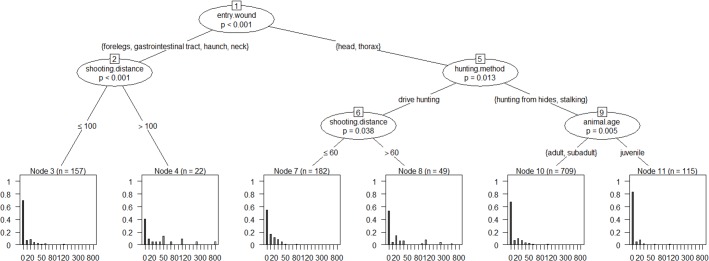
Inference tree for assessment of the factors that influence the escape distance of roe deer (including animals that remained on the spot).The inference tree can be read from top to bottom. The number of the splits (nodes) is shown in the boxes (e.g. 1). Significant variables are indicated at the splits with the significance level in the ellipses. Connections between the nodes show the group distributions. The escape distance is shown as the end node of the inference trees with the help of relative frequencies (with details of the sample size n).